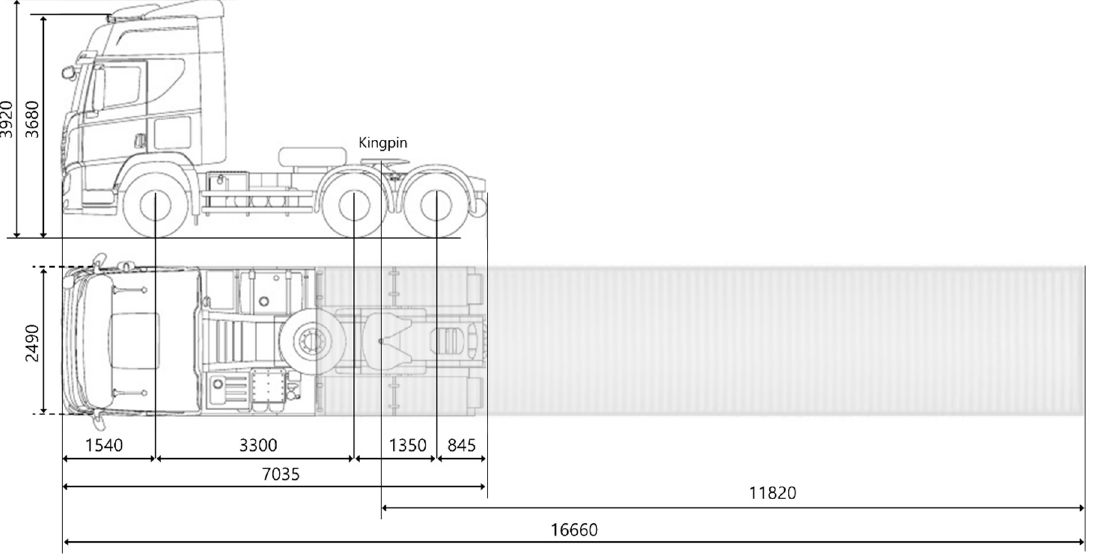
Figure 5. Specification of whole truck (unit: mm).